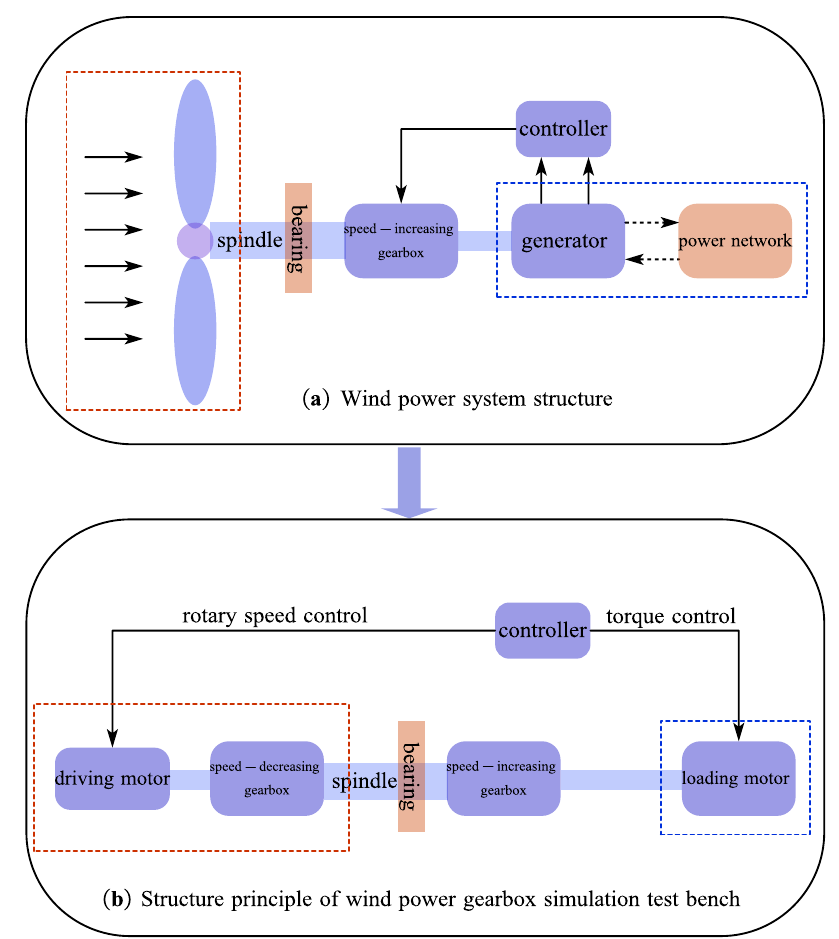
Figure 13. Gear fatigue test platform schematic diagram.